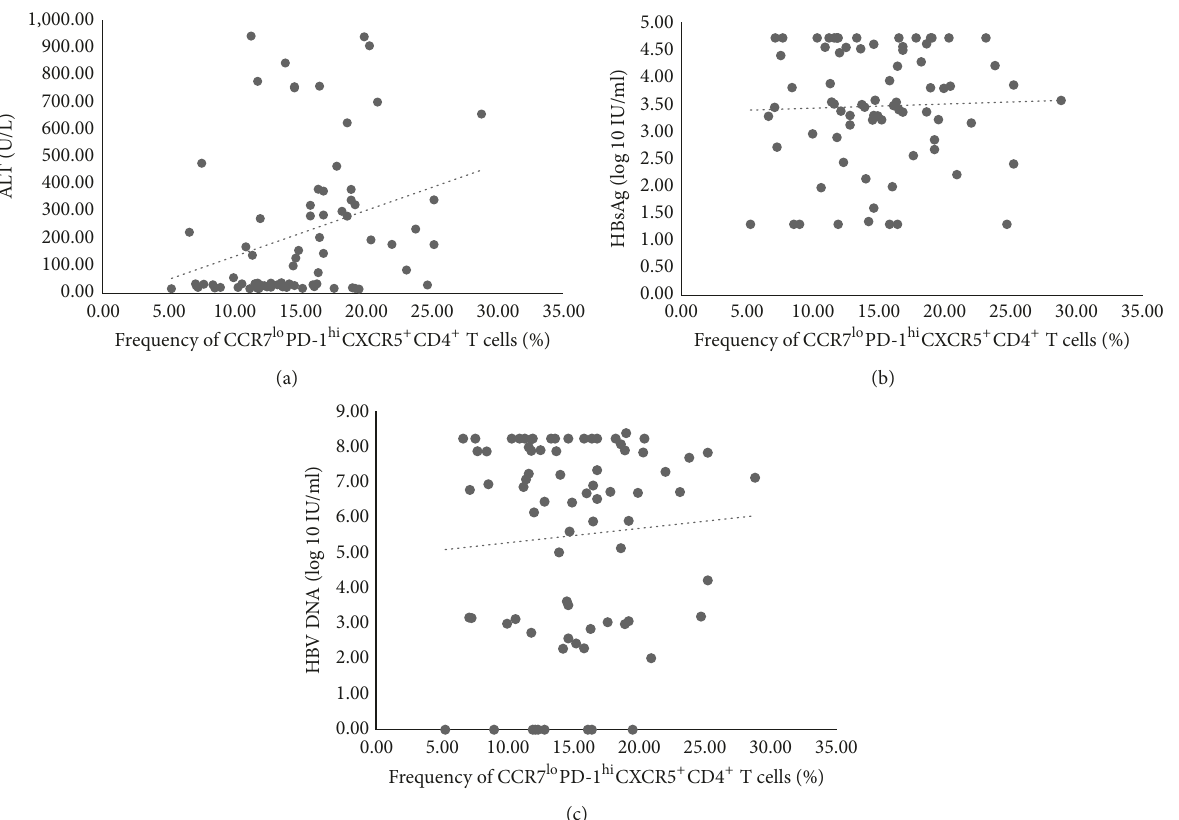
Figure 5: Correlations between frequency of CCR 7 lo PD- 1 hi CXCR5 + CD4 + T cells and clinical indices. (a) Correlation between frequency of CCR 7 lo PD- 1 hi Tfh cells and ALT level (r=0.370, p=0.001). (b) Correlation between frequency of CCR 7 lo PD- 1 hi Tfh cells and HBV DNA load (p > 0.05). (c) Correlation between frequency of CCR 7 lo PD- 1 hi Tfh cells and HBsAg (p > 0.05). Statistical comparison was performed using Spearman’s rank correlation